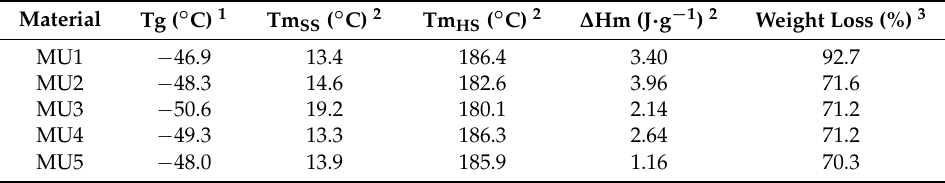
Table 3. Results of thermal properties from DSC, DMA and TGA.